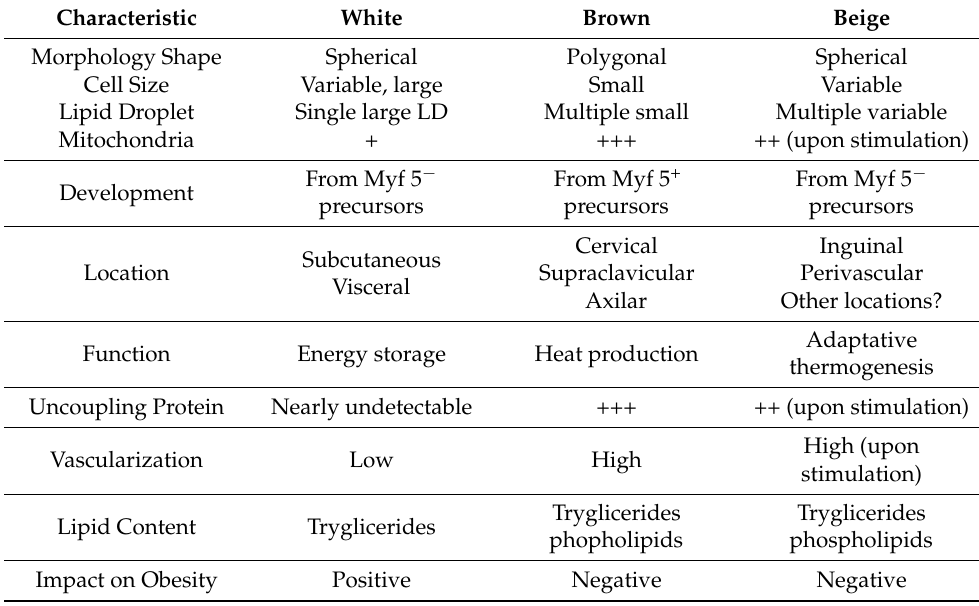
Table 1. Main differences among the three types of adipose tissue. Modified from Cedikova. et al. [16].